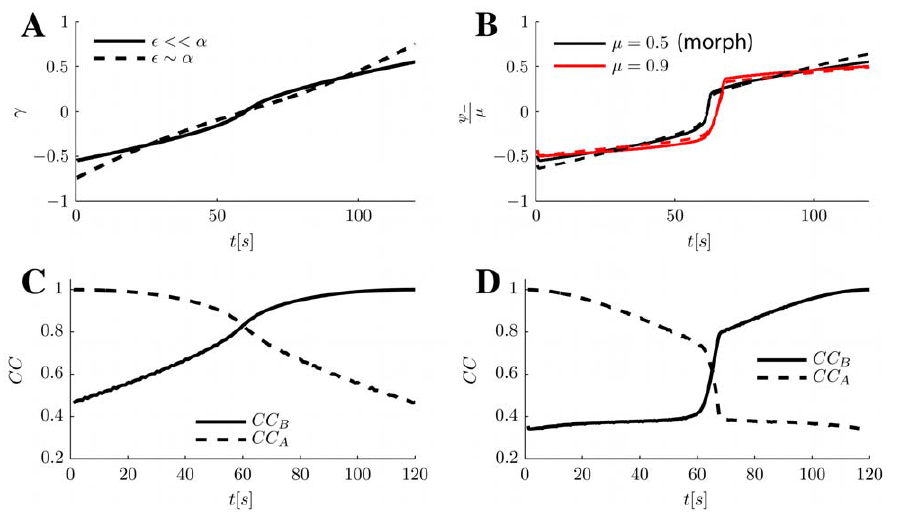
Figure 8. Representation switch along the morph sequence. Slow morph experiment between two reference environments, over T ~ 120 s of simulation. The identity of the environment varies as m ? t ð Þ ~ m ? the morph sequence, or + m for two correlated environments. The input location is also time-varying, Y t ð Þ ~ solution. Order parameter c with time, both for weak * 0 : 1 a (solid curve) and strong external input * a (dashed curve). The result does not depend strongly on the amplitude of the external input. Parameters m ~ 0 : 95, J 1 ~ 6, J 0 ~{ 5, ~ 0 : 05,0 : 5 ð Þ . B: Cylinder regime. Order parameter (location of the bump maximum in r ) for the approximated storage of the morph sequence m ~ weak and strong input. Note how the sharpest transition, is exhibited by the weakly correlated maps. For the cylinder regime, the result is only mildly